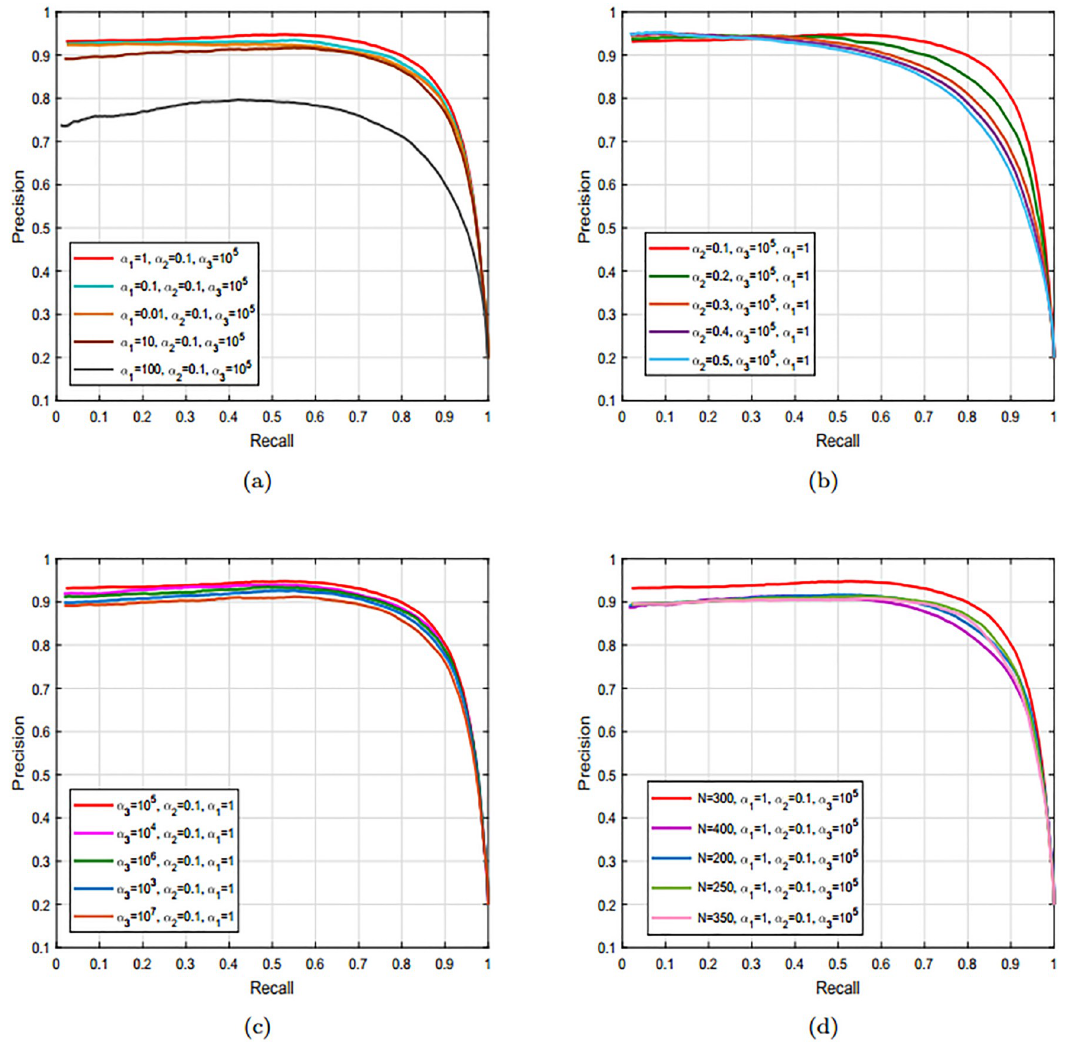
Fig 7. Impact of different key parameters on the performance of our designed framework using the MSRA dataset [38]. (a) A series of PR-curves obtained with varying the values GR parameter. (b) The PR-curve obtained using the different values of the sparsity parameter in the range starting from {0.1} to {0.5}. (c) The impact of MMR parameter with varying its values in the range between {10 3 , 10 7 }. (d) The impact of the number of superpixels on the performance of the proposed